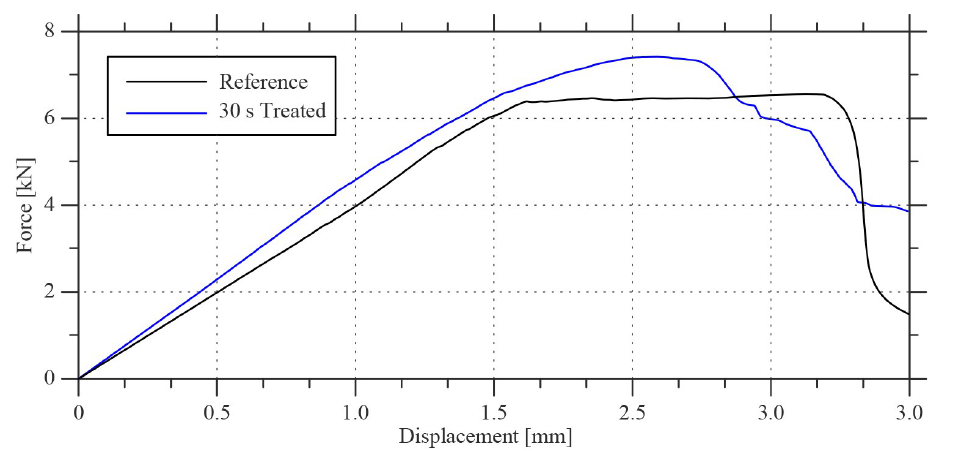
Figure 6. Force-displacement diagram of cement samples containing